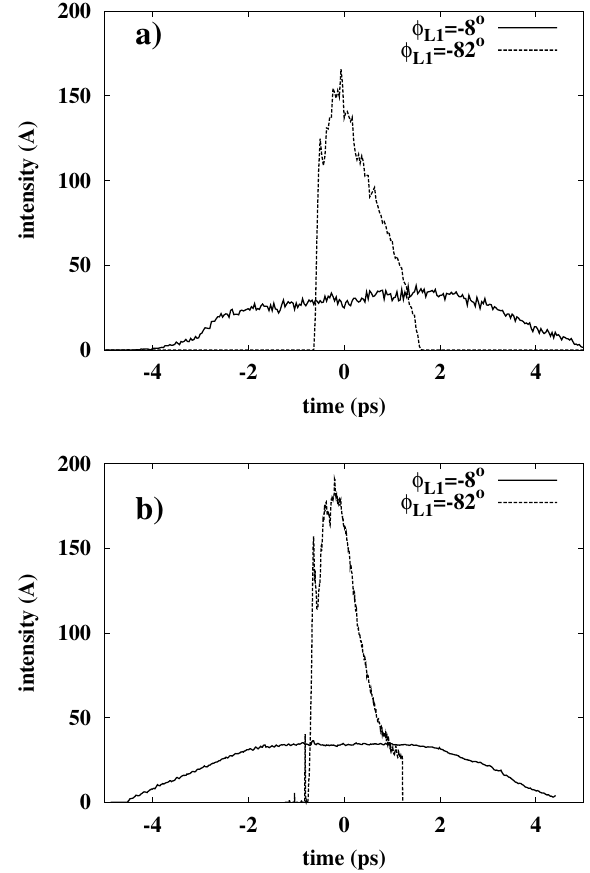
FIG. 6. Comparison of the bunch time profile for L1 (cid:4) 8 (cid:12) and (cid:4) 82 (cid:12) off crest. (a) was generated by tracking simulation; (b) is a direct measurement using the zero-phasing method. The time > 0 corresponds to the bunch tail